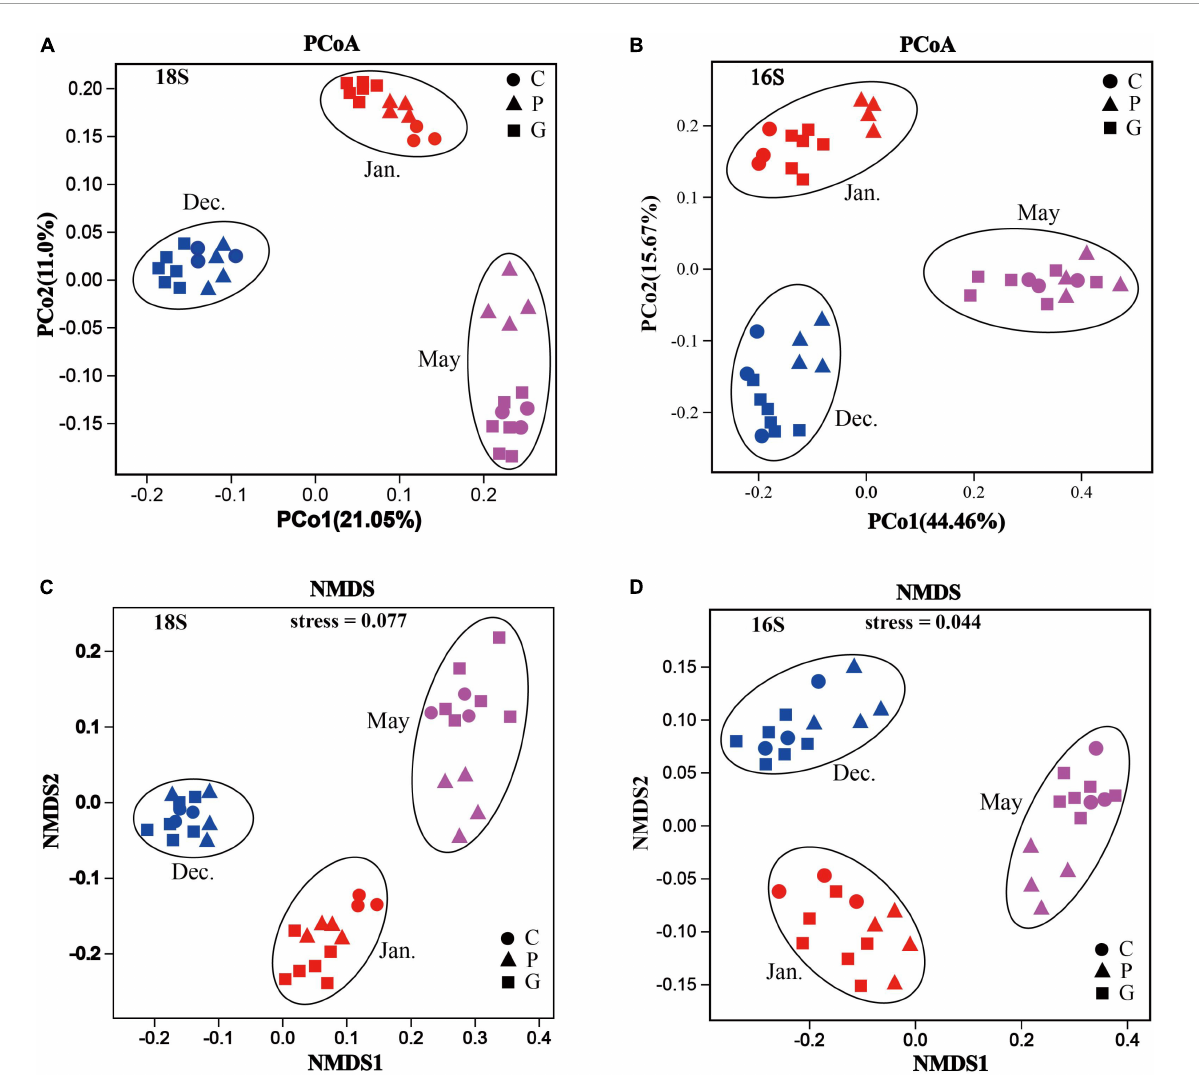
FIGURE4 Microbial community structures and identification of patterns based on Bray–Curtis distances in different zones during the various cultivation stages. Principal coordinates analysis (PCoA) plot: all samples (zones C, P, and G) taken in different months based on 18S rRNA genes (A) and 16S rRNA genes (B) of all the OTUs. Non-metric multi-dimensional scaling analysis (NMDS) plot: all samples (areas C, P, and G) taken in different months based on 18S rRNA genes (C) and 16S rRNA genes (D) of all the OTUs.